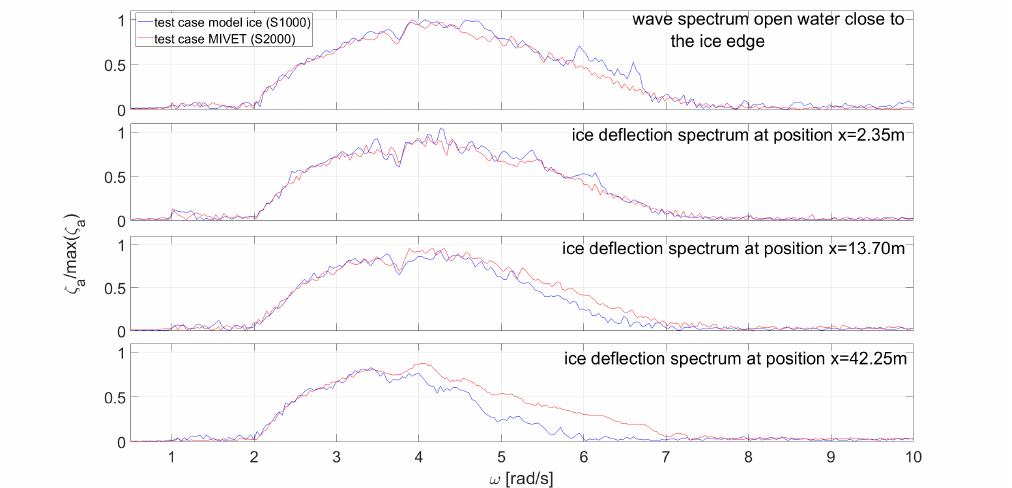
Figure 9. Change of the wave spectra in the two ice sheets over four measurement locations along the length of the tank. The attenuation of the conventional model ice, S1000, is more pronounced than for